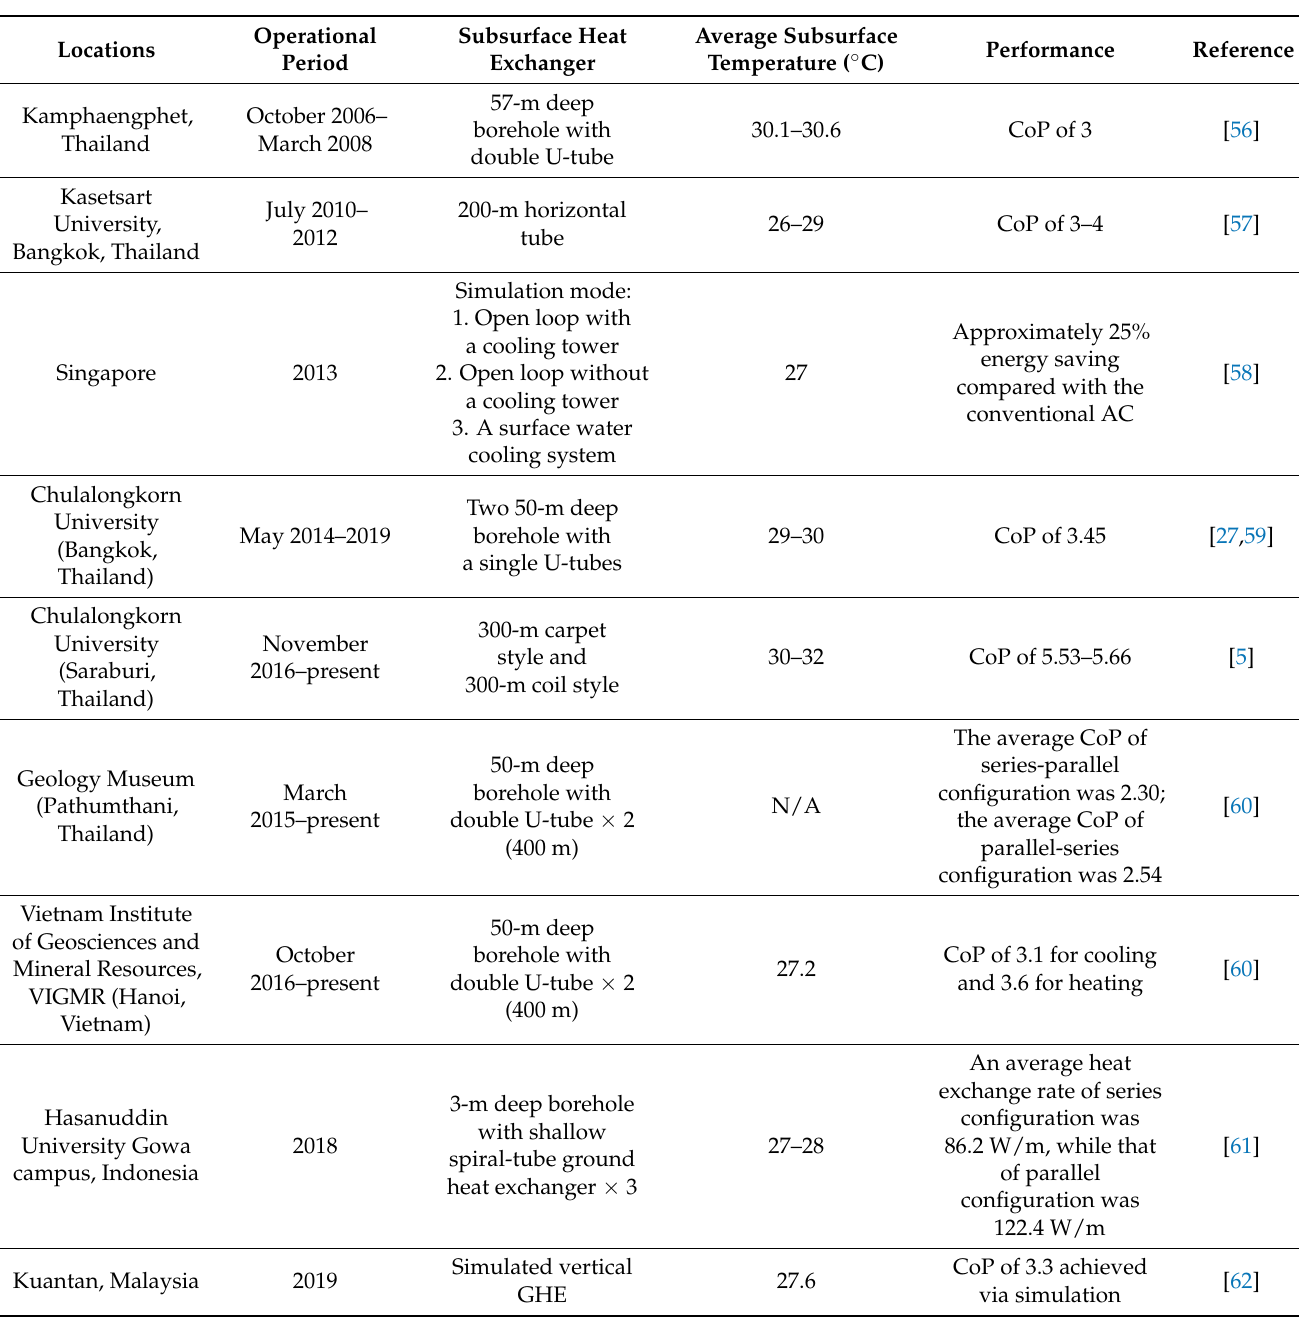
Table 1. Experimental sites of GSHP in Southeast Asia in tropical climates (modified after Yasukawa and Uchida